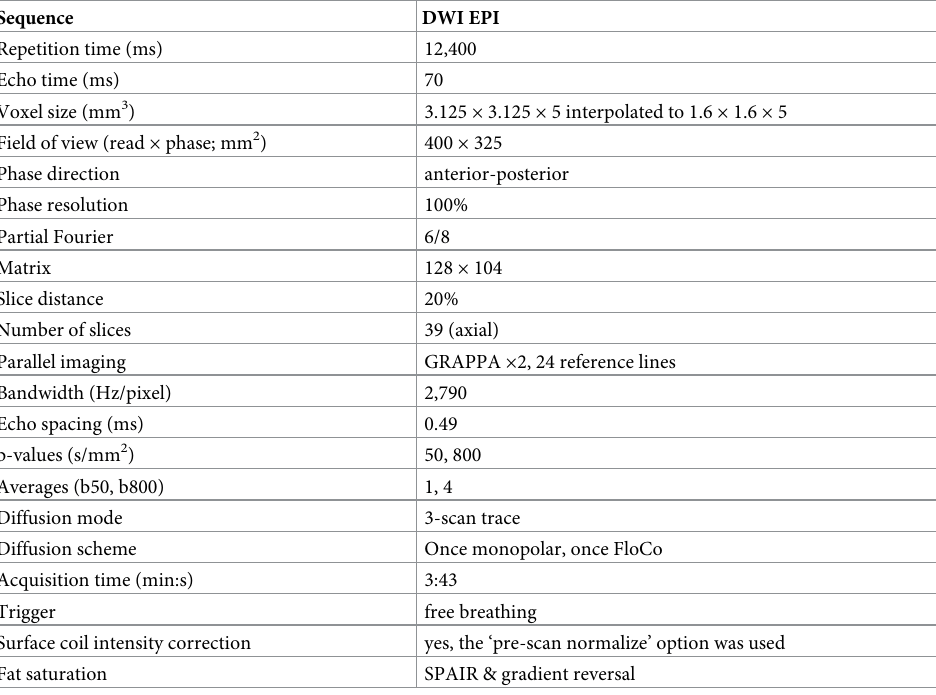
Table 1. MRI sequence parameters for FloCo and monopolar DWI